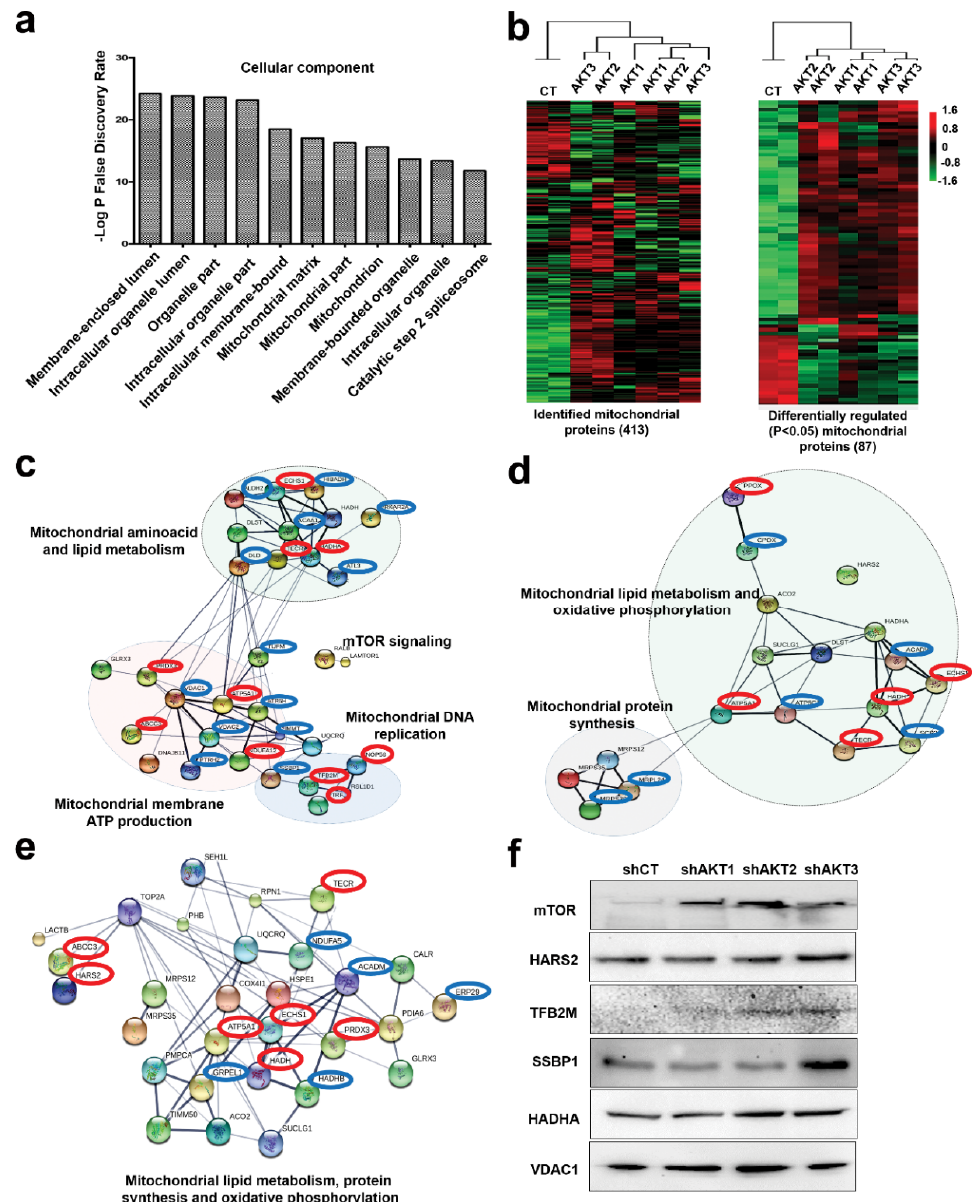
Figure 2. The mitochondrial proteome is significantly altered in cells adapted to AKT silencing. ( a ) Bar graph with the top ten main cellular components in adapted cells to AKT silencing identified using STRING. ( b ) Left, cluster analysis of the identified mitochondrial proteome using two biological replicates per cell line (shown on top), represented by a heatmap. Right, the same as left but with significantly (P < 0.05) regulated mitochondrial proteins between the cell lines (P < 0.05) identified by ANOVA. ( c ) Functional interactomes with significantly upregulated proteins (P < 0.05) in cells adapted to AKT1 silencing compared to control cells, and to AKT2 silencing ( d ) and AKT3 silencing ( e ). In red, common upregulated proteins present in the three interactomes. In blue, upregulated proteins specific for the adaptation to the indicated AKT kinases. Thin and thick lines shown interactions with medium (0.7) or high (0.9) confidence by STRING. Regulated cellular processes by the functional interactome subgroups are highlighted and indicated. ( f ) Expression of the indicated proteins by Western blot in control cells and in cells adapted to silencing of the indicated AKT isoforms. Original uncropped Western blots and densitometry readings are shown in Figure S3–S8.